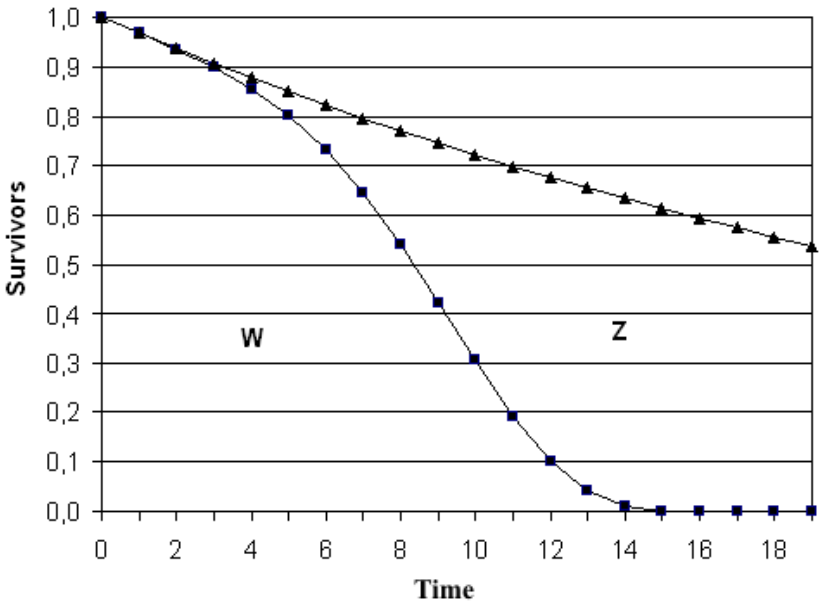
FIGURE 3. Life table of Panthera leo (F) with ( ■ ) and without ( ▲ ) intrinsic mortality. With a low extrinsic mortality ( m 0 , see the slope of curve ▲ ) the value of P s (area Z) is high.